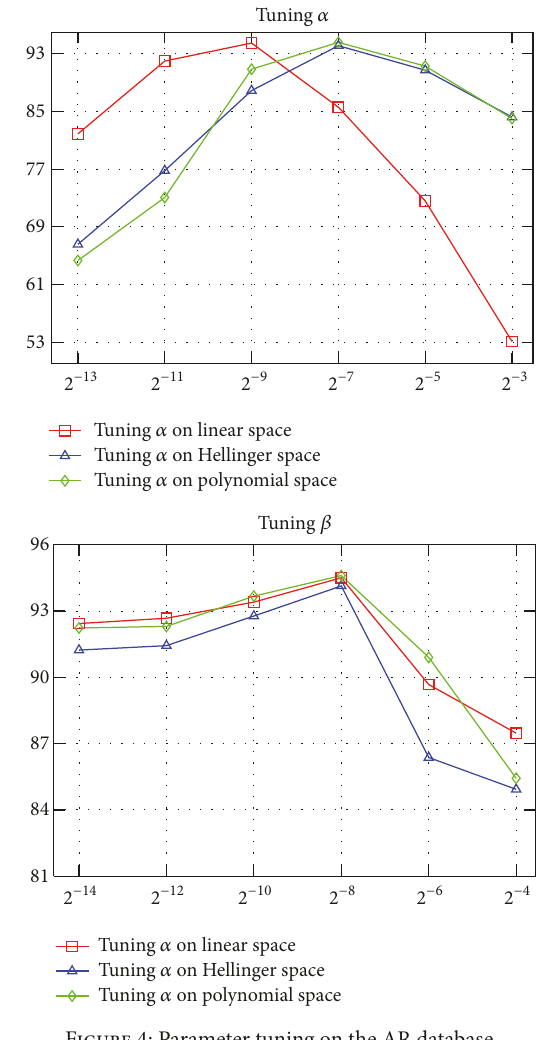
Figure 4: Parameter tuning on the AR